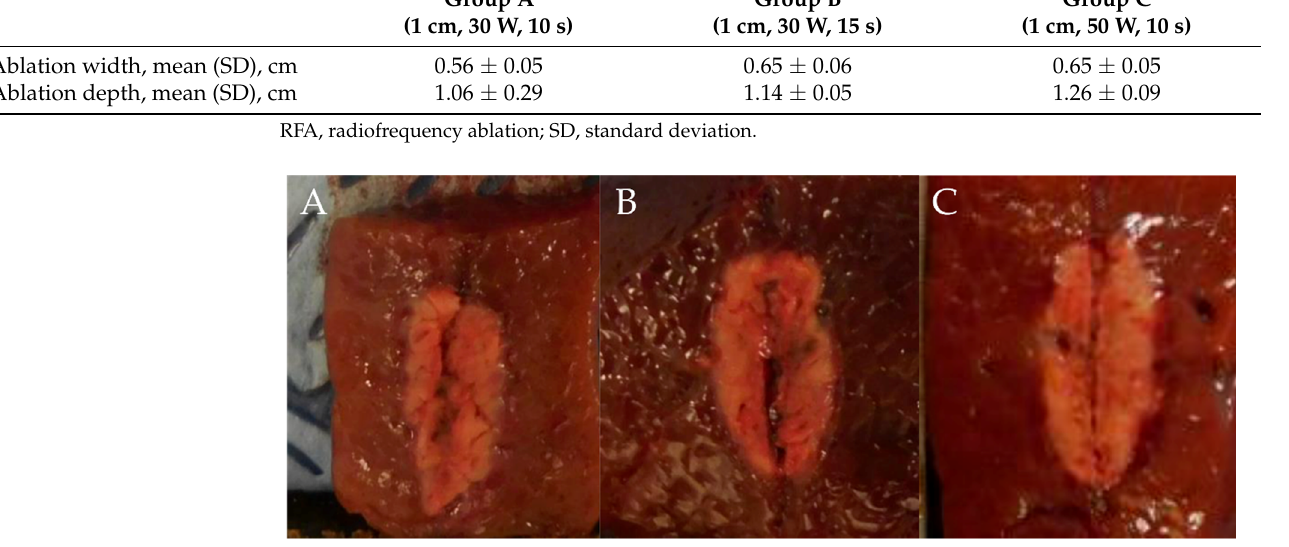
Figure 4. Comparison of ablation zones based on the ablation power and ablation time. ( A ) 1 cm, 30